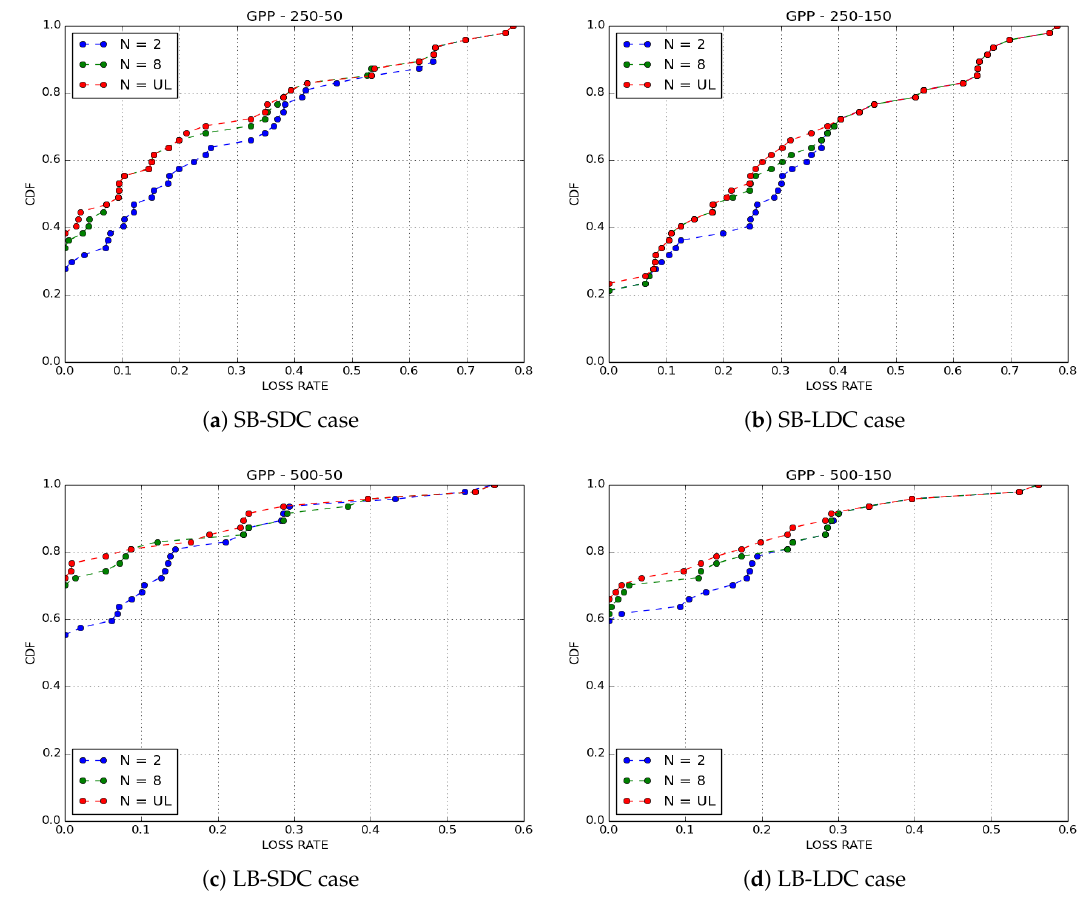
Figure 9. Loss rate for GPP buffer management policy.